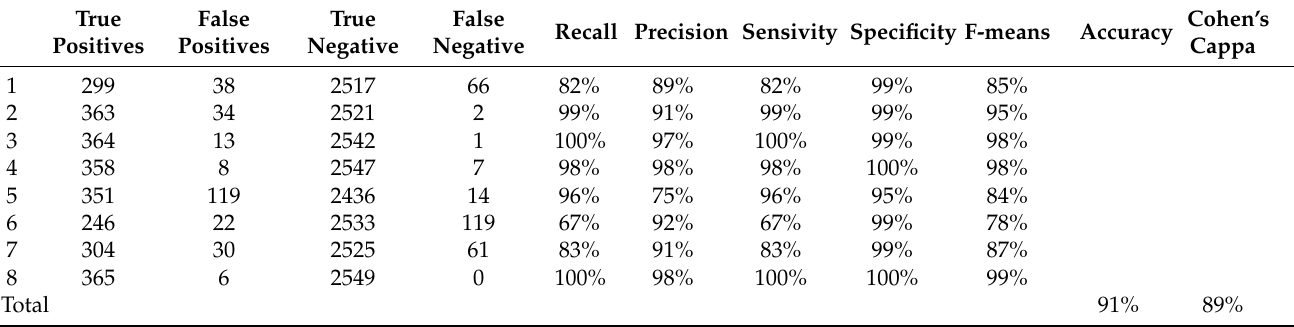
Table A1. The activity classification results for sensor s 1 .